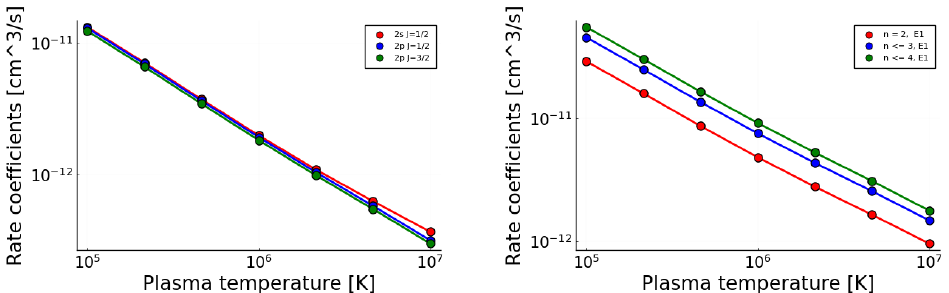
Figure 5. The same as in Figure 4 but for the fine-structure and shell-resolved RR plasma rate coefficients. Left panel: Capture into the 2 s J = 1/2 (red line), the 2 p J = 1/2 (blue line) and 2 p J = 3/2 level (green line). Right panel: Capture into all levels with n = 2 (red line), n = 3 (blue line), and n = 4 (green line).